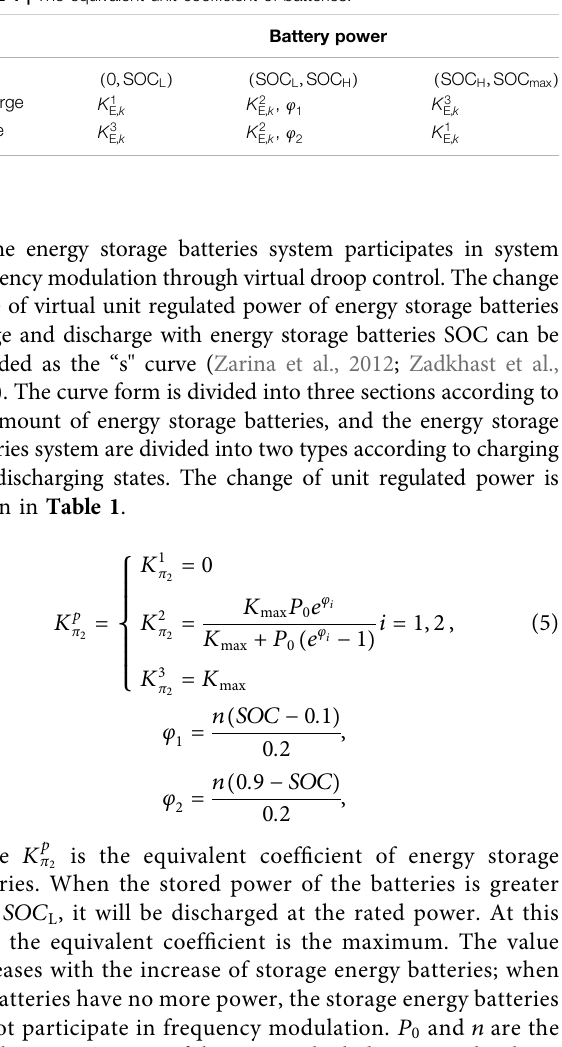
TABLE 1 | The equivalent unit coef fi cient of batteries.